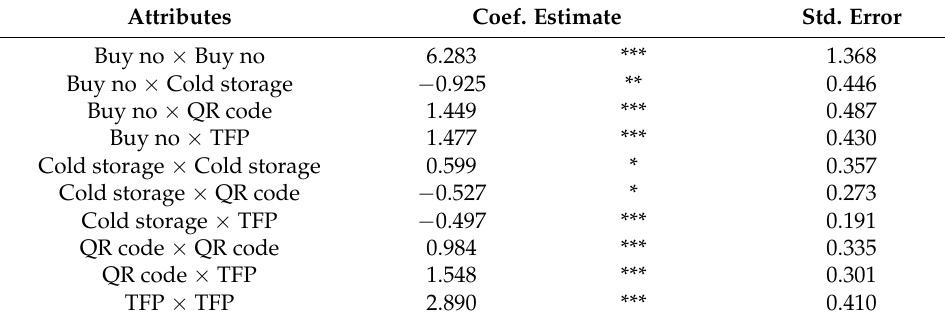
Table 4. Estimation for the random